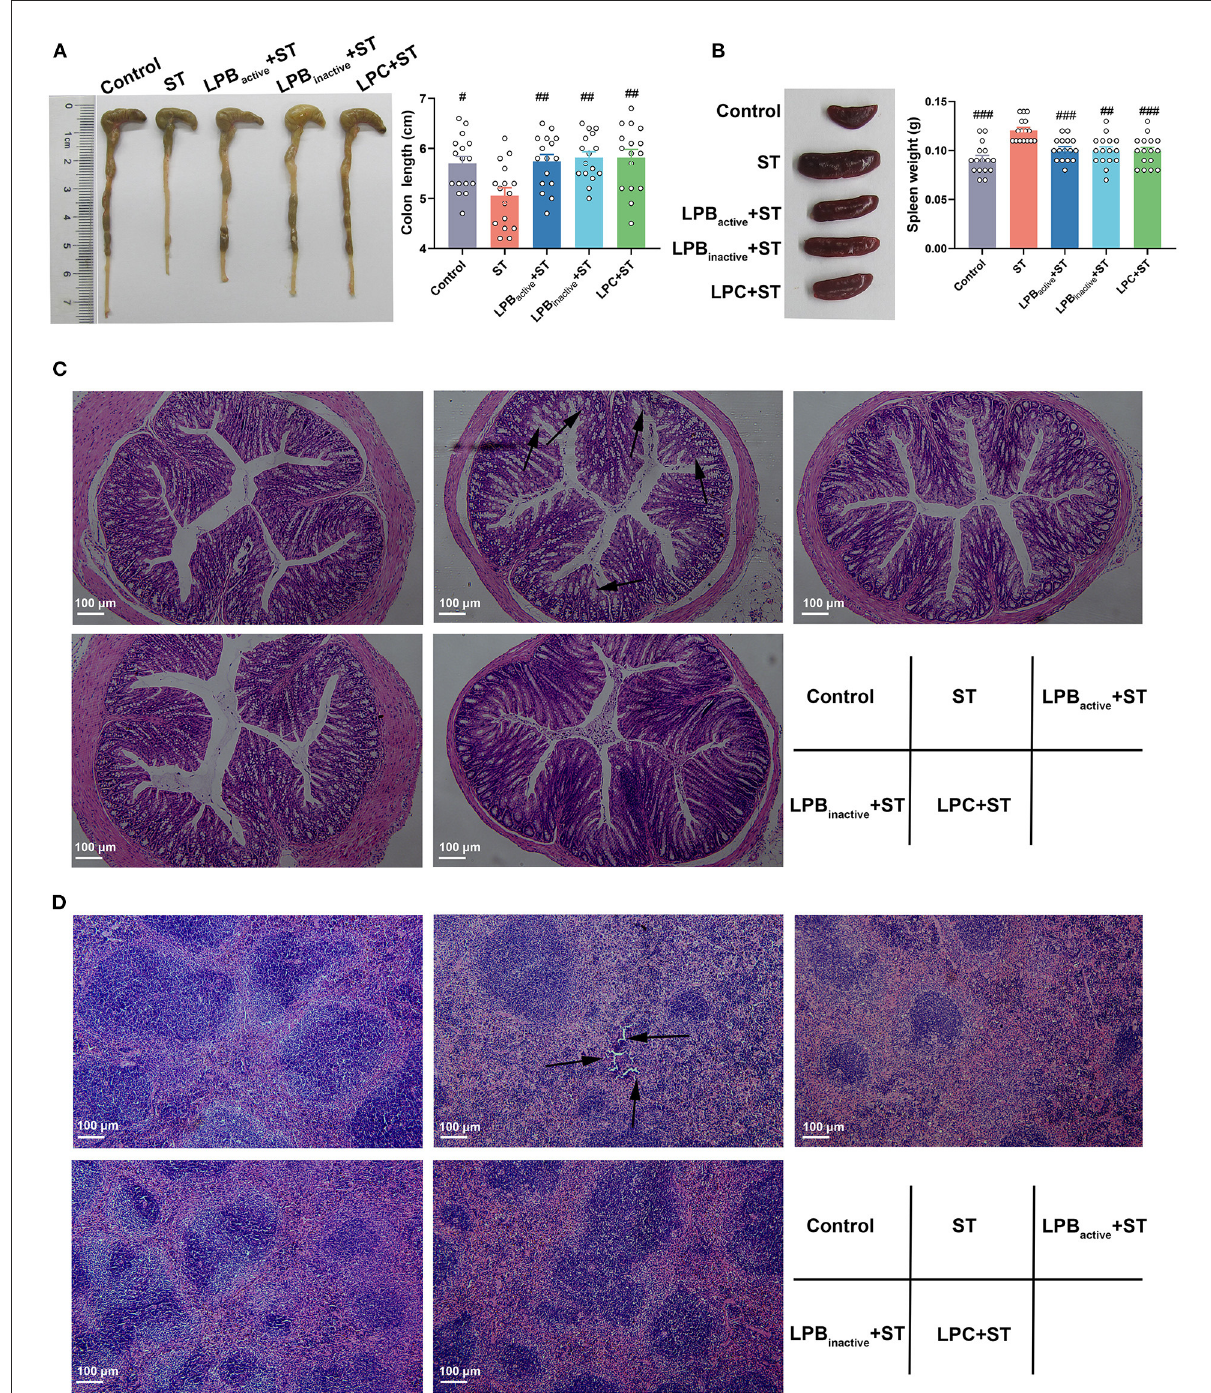
FIGURE3 The LP postbiotics suppress tissue injury under ST challenge. (A) Pictures of colon and statistical analysis of colon length; (B) Pictures of spleen and statistical analysis of spleen weight. The data shown as mean ± SEM were analyzed by one-way ANOVA and Tukey’s test ( N = 16 in each group). # Indicates the significance compared to ST group: # p < 0.05, ## p < 0.01, ### p < 0.001. (C,D) Histomorphometric analysis of colon and spleen by H&E staining. 100 × magnification, scale bar: 100 µ m. The arrows indicate the damaged